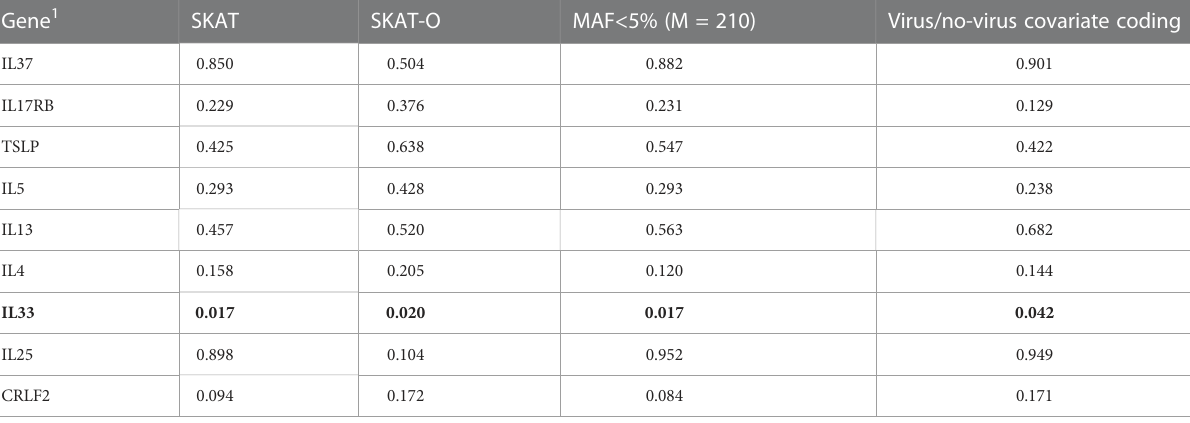
TABLE 5 Sensitivity analysis results (P-values).